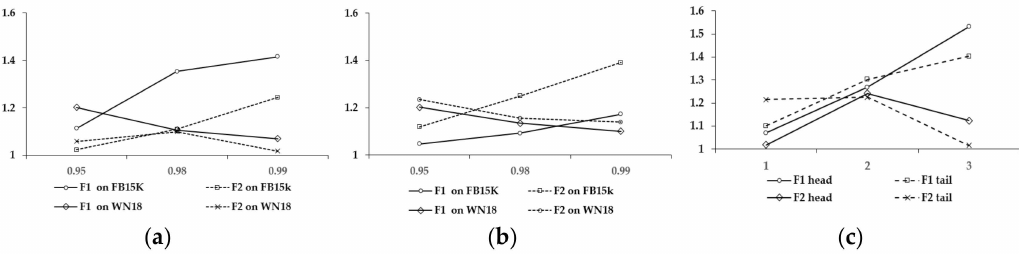
Figure 2. The result of TransOnLine compared with TransE. ( a ) The result of head prediction where step l = 1; ( b ) the result of tail prediction where step l = 1; ( c ) the result of TransOnline with di ff erent steps l